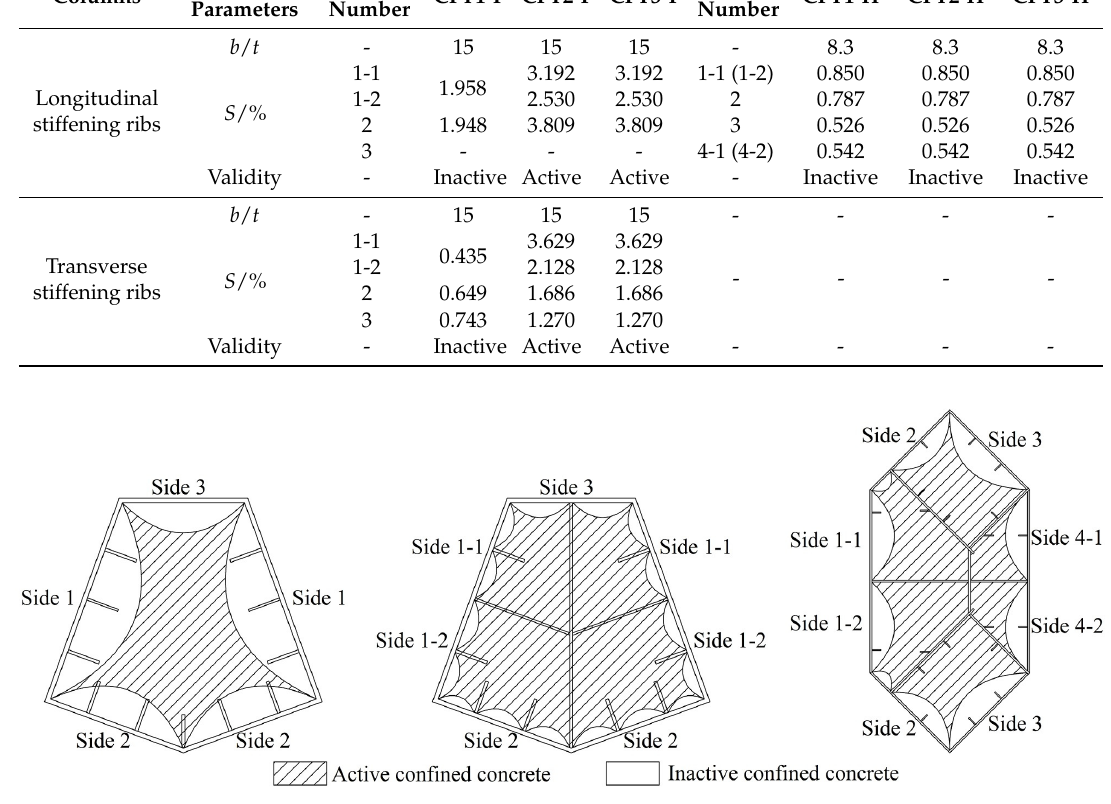
Figure 10. The active confined concrete and inactive confined concrete.